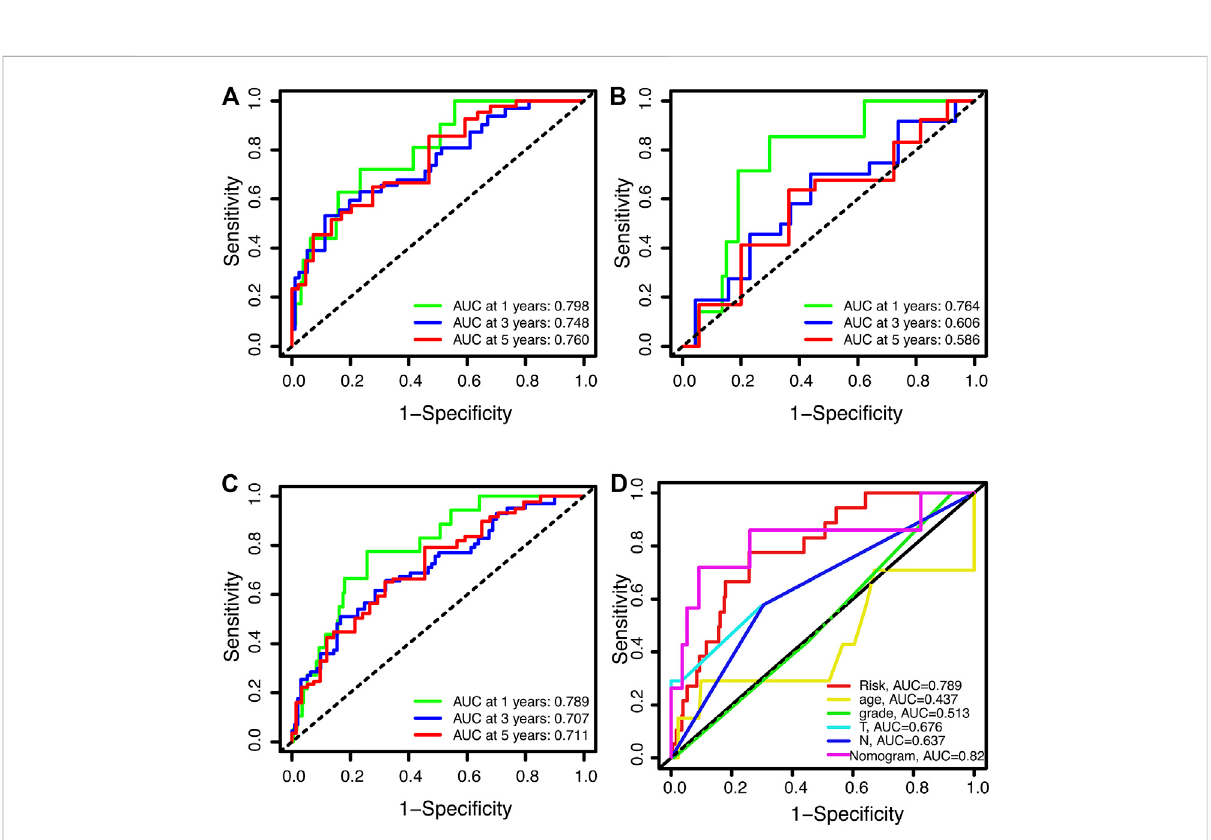
FIGURE 5 Receiver operating characteristic curves for overall survival (OS). (A,B) ROC curves for 1-year, 3-year, and 5-year OS in training (A) , testing (B) , and the entire sets (C) , respectively. (D) The 1-year OS ROC curves foe signature, clinical features and